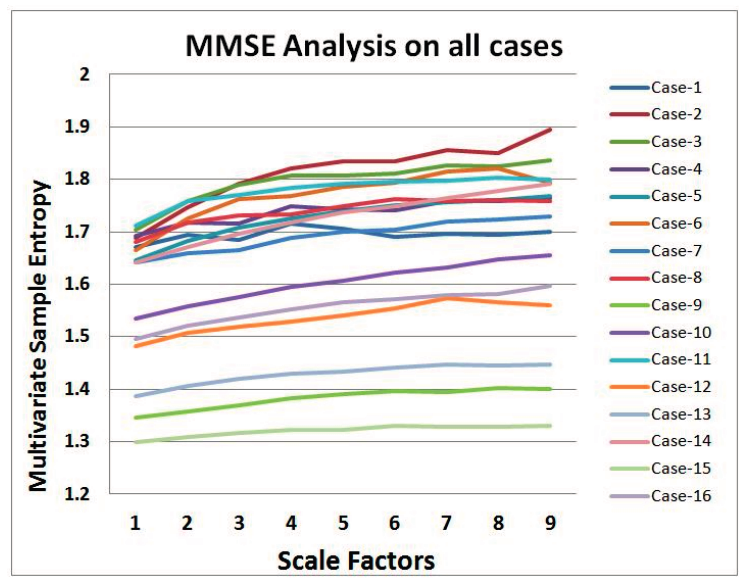
Figure 7. MMSE analysis for the 16